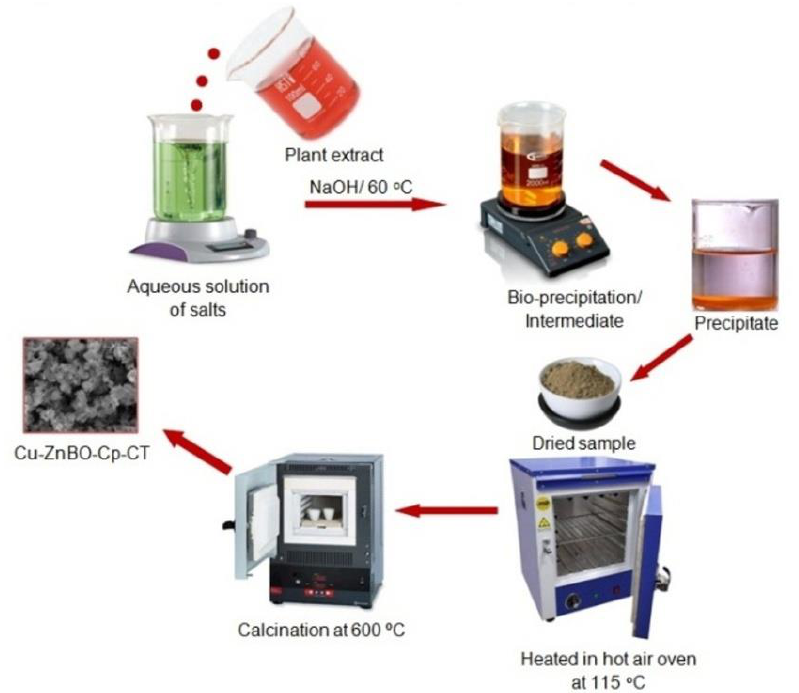
Figure A1. Schematic diagram of preparation of Cu-ZnBO-Cp-CT.